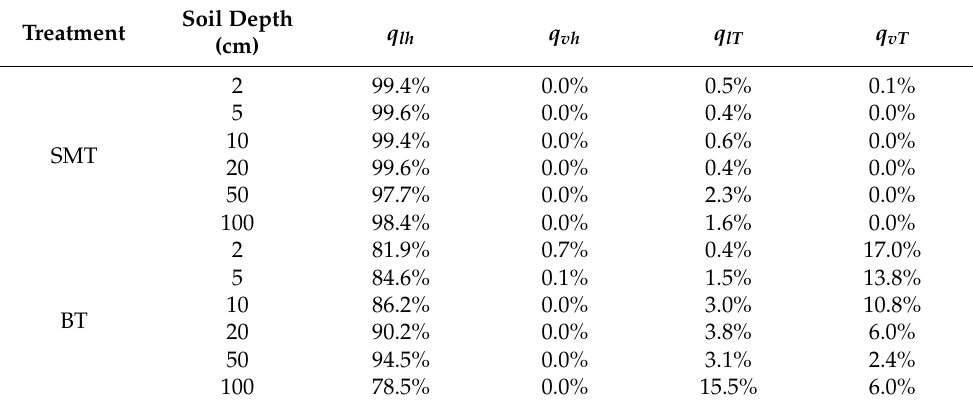
Table 5. The proportion of each soil water fl ux component to total fl ux during a 3-day period before and after irrigation for SMT and a dry period for BT.